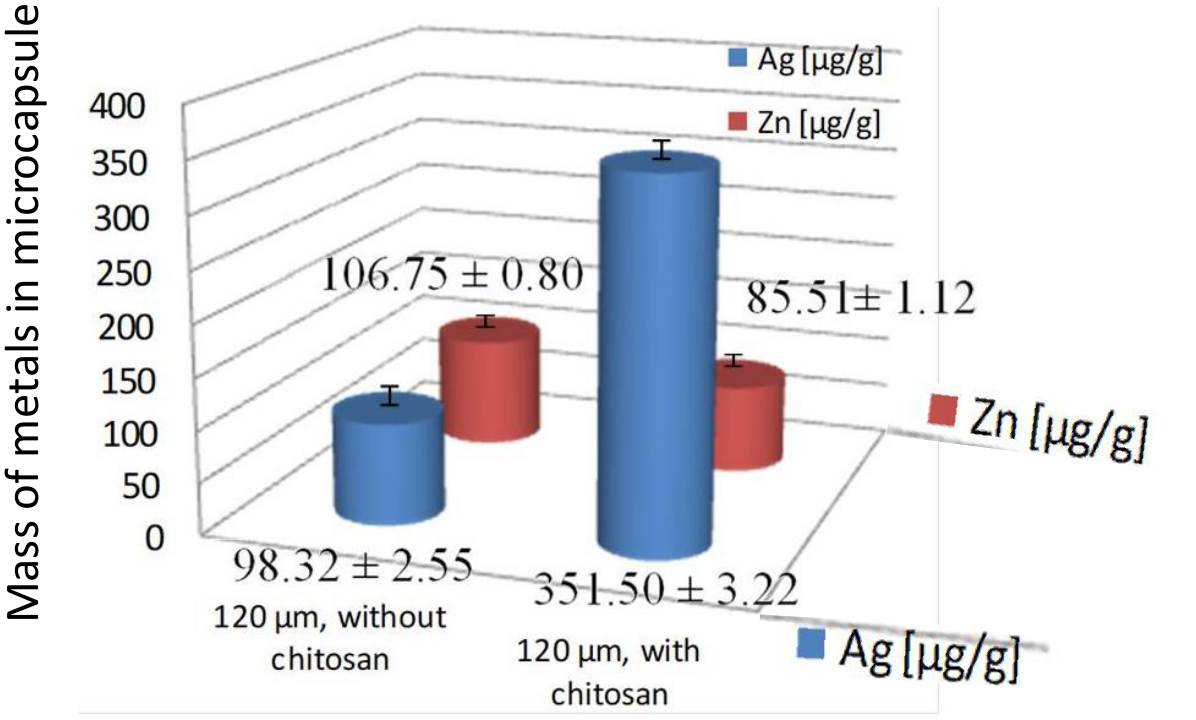
Figure 6. Concentration of silver and zinc in samples of 120 μm microcapsules prepared with and without the chitosan.